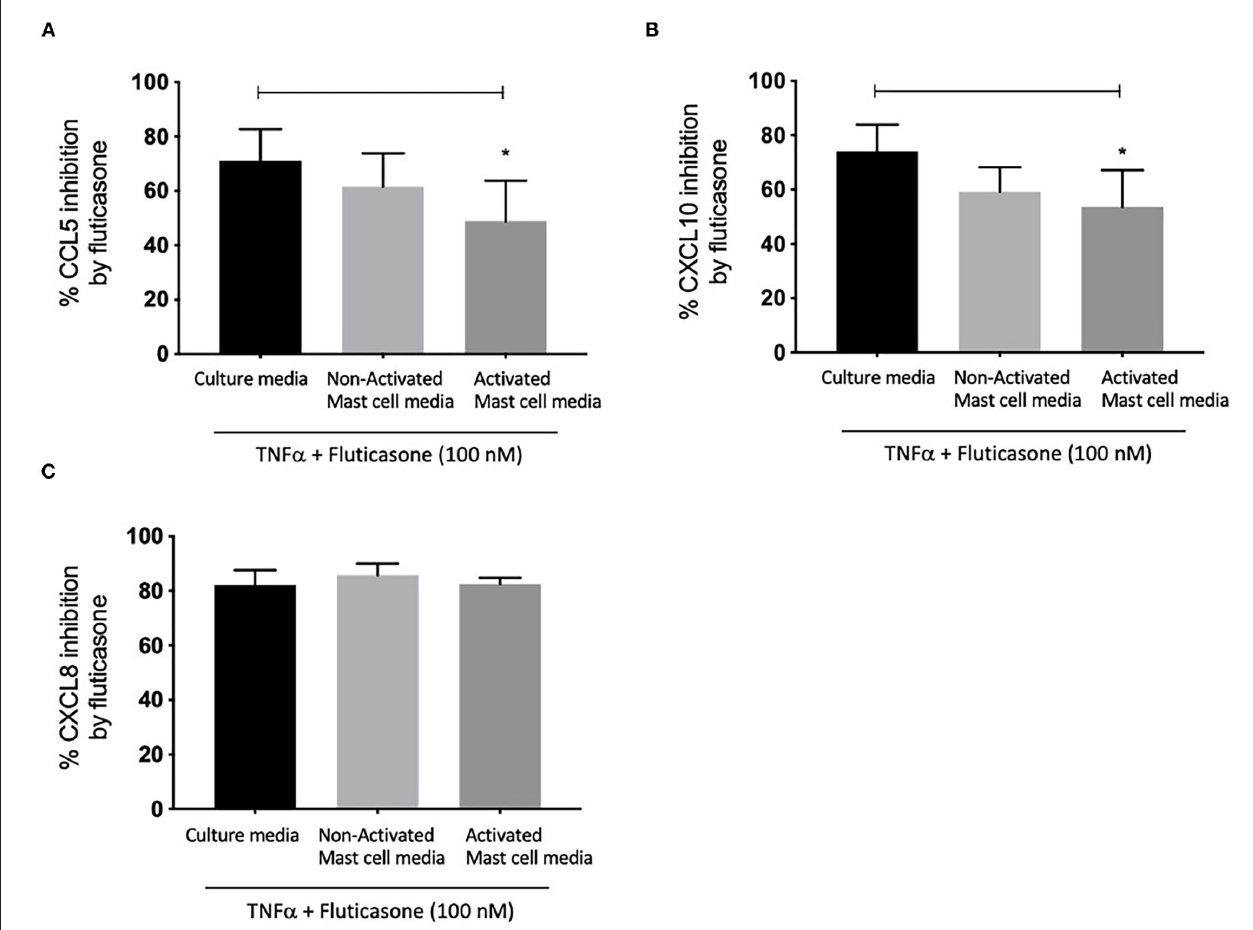
FIGURE 2 | Inhibition of TNF α -induced-chemokines by fluticasone in ASM cells pre-treated with conditioned media from 24-h activated mast cells. Healthy ASM cells were pre-treated with control mast cells media, 24-h non-activated and activated mast cell conditioned media. ASM cells were then washed and stimulated with TNF α (10ng/ml) with or without fluticasone (100nM) for 24h. Expression of CCL5 (A) , CXCL10 (B) , and CXCL8 (C) was assessed by ELISA with data presented as % of the chemokine responses in cells treated with TNF α alone (Means ± SEM of n = 6 different cell lines) (* p < 0.05). Comparisons between groups were made using one-way ANOVA and Tukey Test